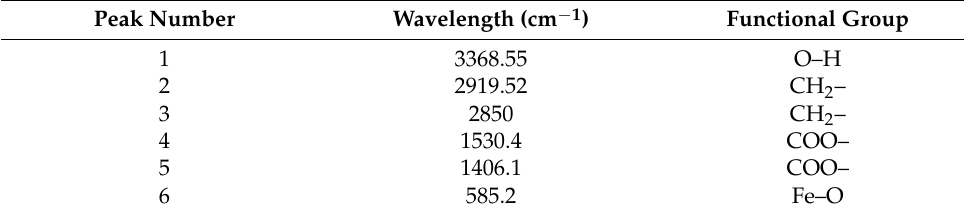
Table 2. List of peaks from FT-IR results.